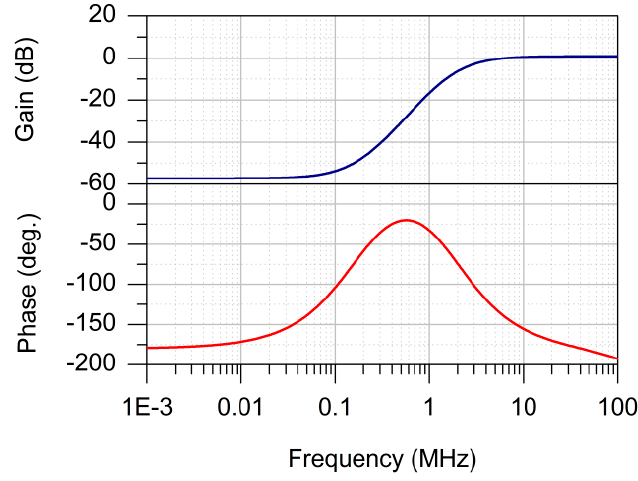
Figure 17. Frequency responses for gain and phase of the third-order HP filter.